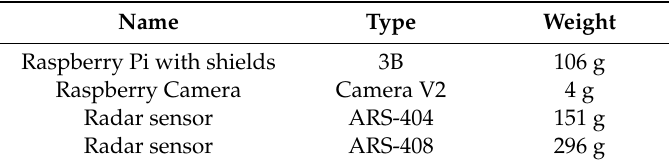
Table 3. Weight of the components of the measurement